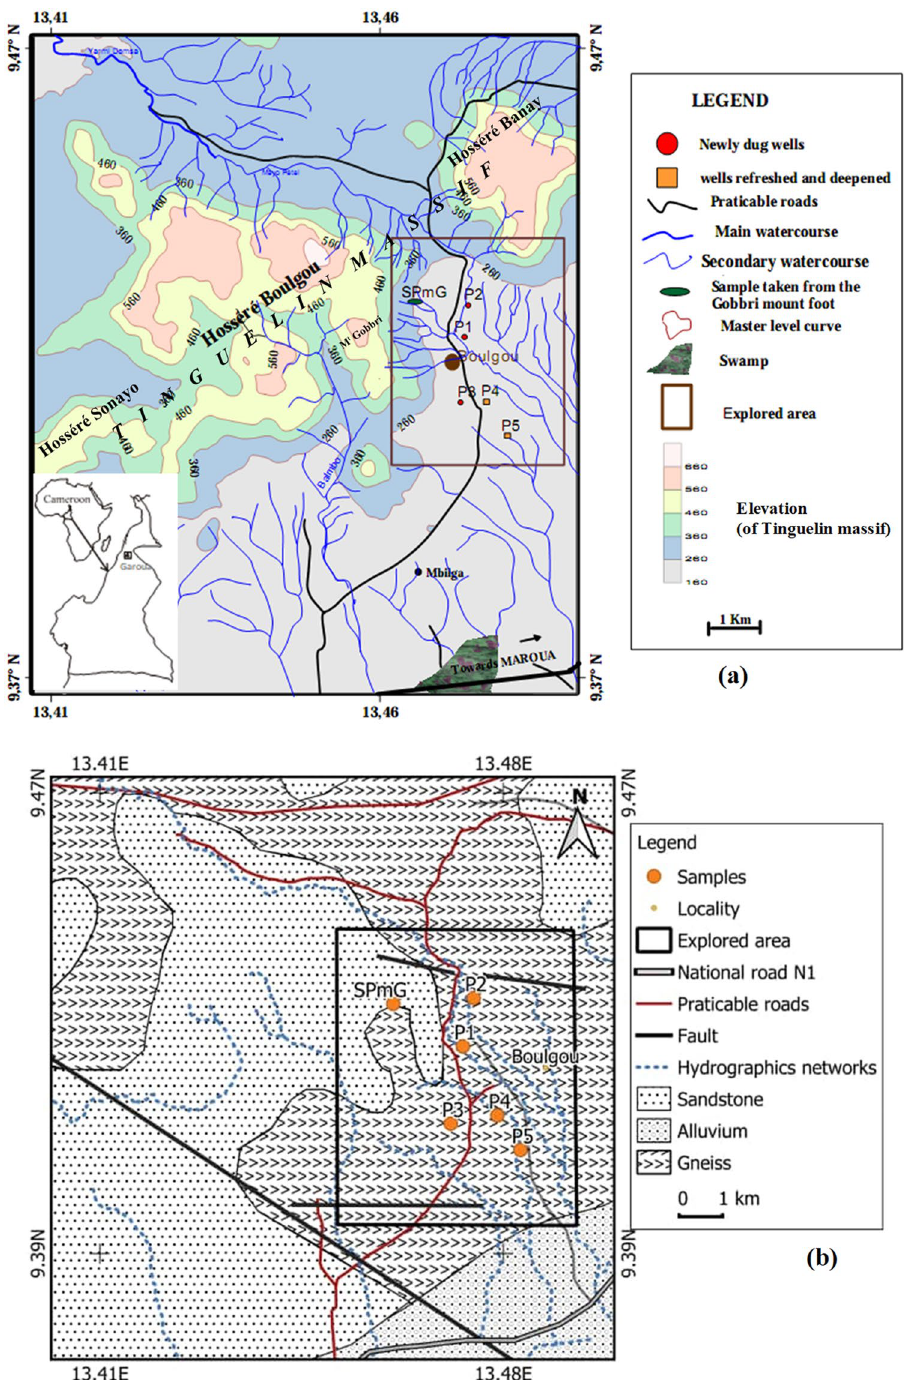
Fig. 1 a Sampling map superposed on the geomor- phological map of Garoua 07253—1d—NC -33-VIII-1d 3 at 1/50 000 scale; b Geological map of the study